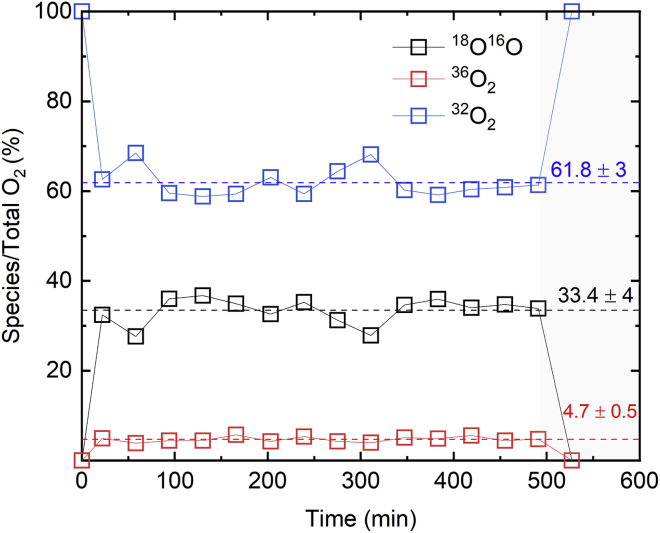
Isotopic Mass Distribution at O2 Retention Time of GCFor channels m/z = 32 (32O2), m/z = 34 (16O18O), and m/z = 36 (36O2), obtained by integration of molecule counting around O2 retention time, after 12 min of sample illumination during 500 min under identical conditions (gray graph background indicates light-off time interval), but 4-mL suspension using a ratio of 1:3 in weight of H218O (97%18O) to H2O (in dashed lines, O population statistic of mean ± SD).